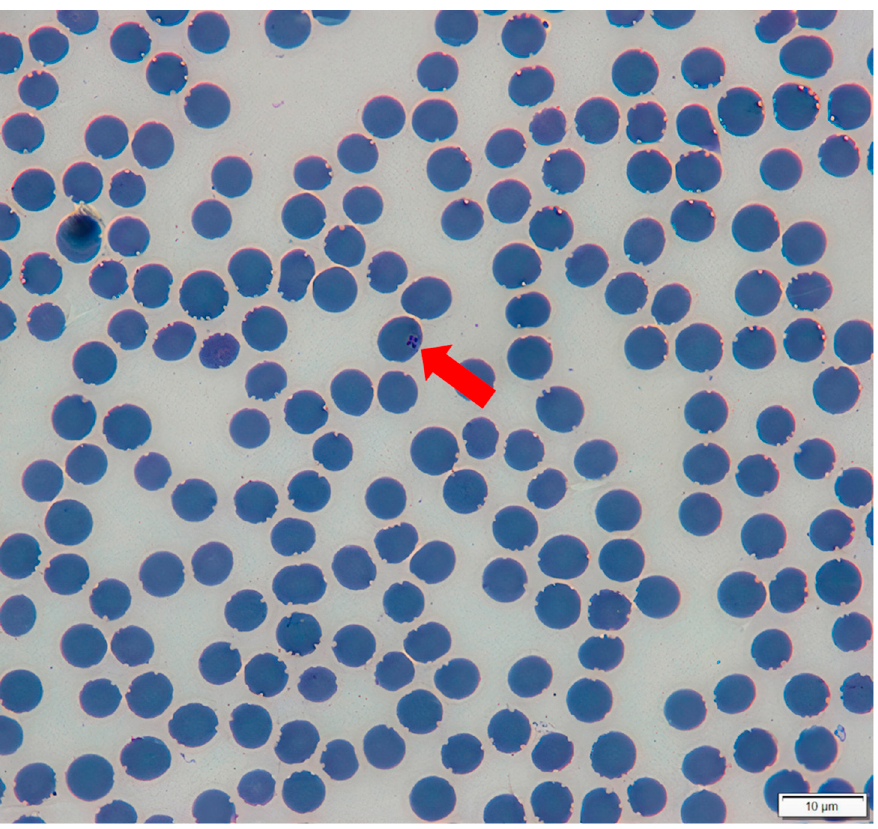
Figure 6. Maltese-Cross inclusions suggestive of Theileria spp. found in erythrocytes of Tapirus terrestris (indicated by the red arrow). Visualization was made by using a light microscope (1000 × ), during blood smear examination. The animal (ID: PO-P) was positive in a PCR protocol that amplify a fragment of approximately 1500 bp of the 18S rRNA gene from piroplasmids [23,24] in the present study.